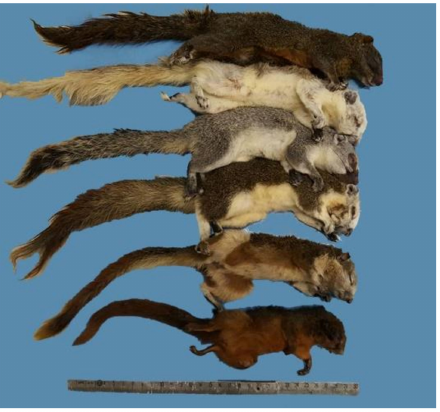
Figure 1. Variable squirrels ( Callosciurus finlaysonii Horsfield,